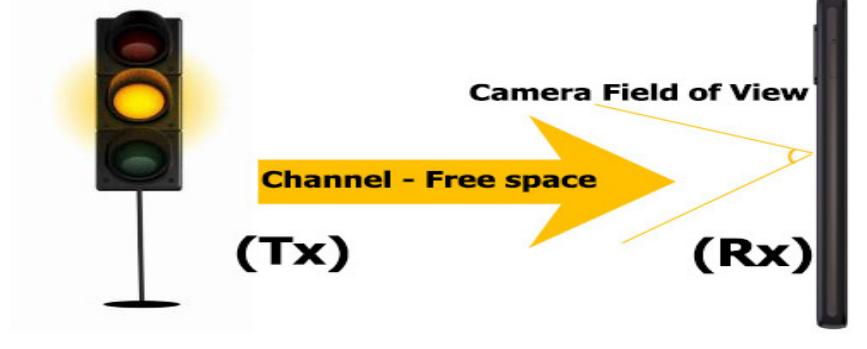
Figure 8. Illustration of an S-VLC communication system, which uses smartphones for reception and a street light for transmission.